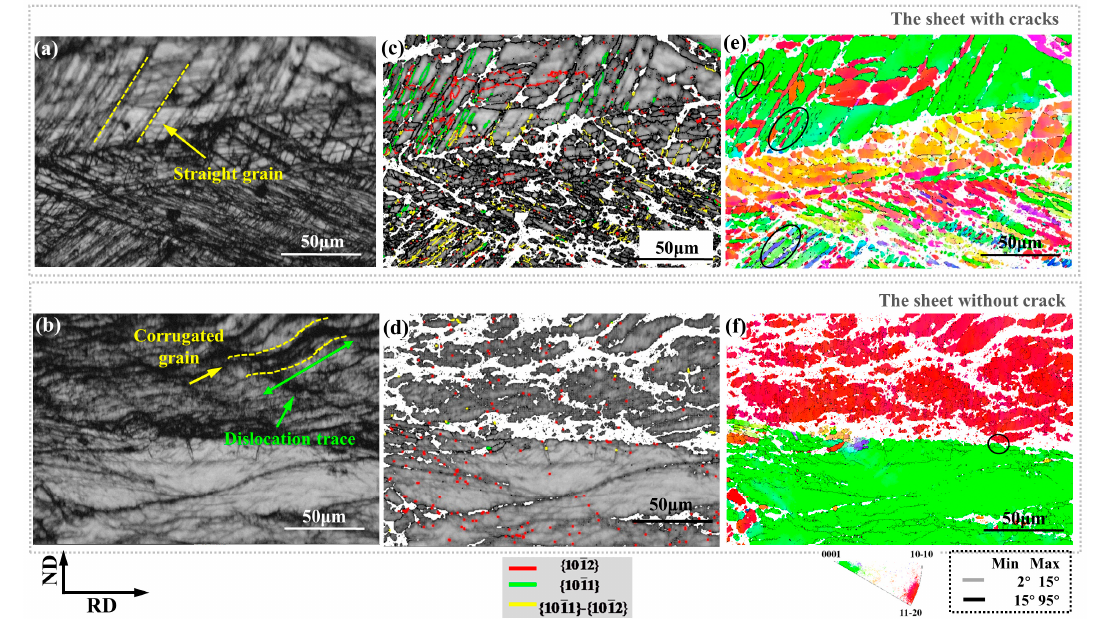
Figure 8. EBSD results of the edge of the sheet with cracks and without cracks. ( a , b ) Band contrast. ( c , d ) Band contrast with three kinds of twins. ( e , f ) Inverse pole figures.